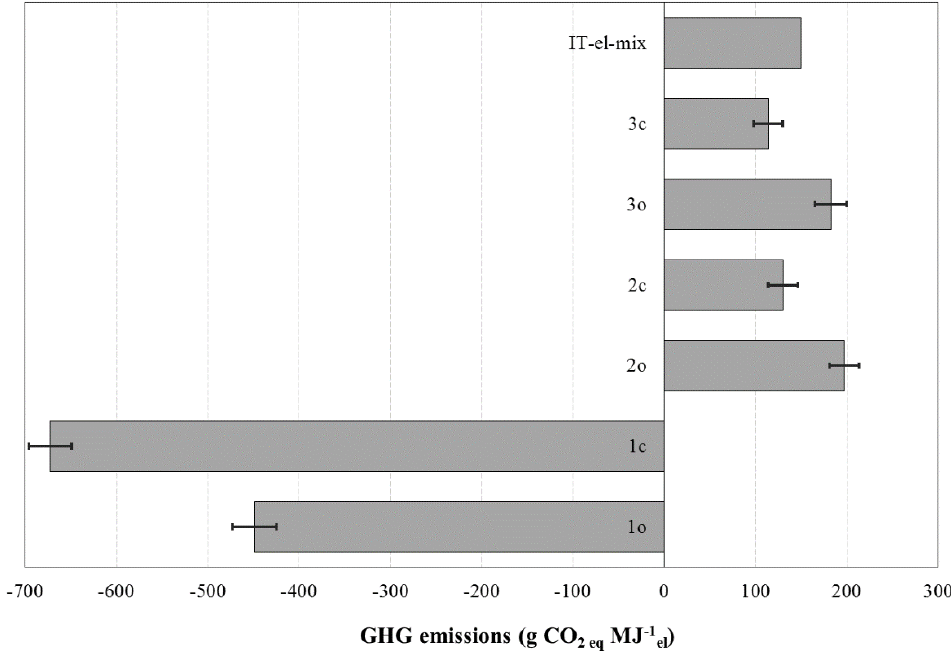
Figure A3. Results of the assessment of the sensitivity of the total GHG emissions to the variability of biogas plants leakages and methane slip through the gas engine. The grey bars represent the total GHG emissions of the analysed systems, the black error bars represent how the total GHG emissions range by varying the leakages and the methane slip by + or −